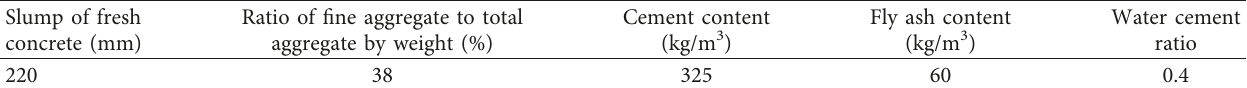
Figure 1: Test beam details. Table 1: Concrete properties.